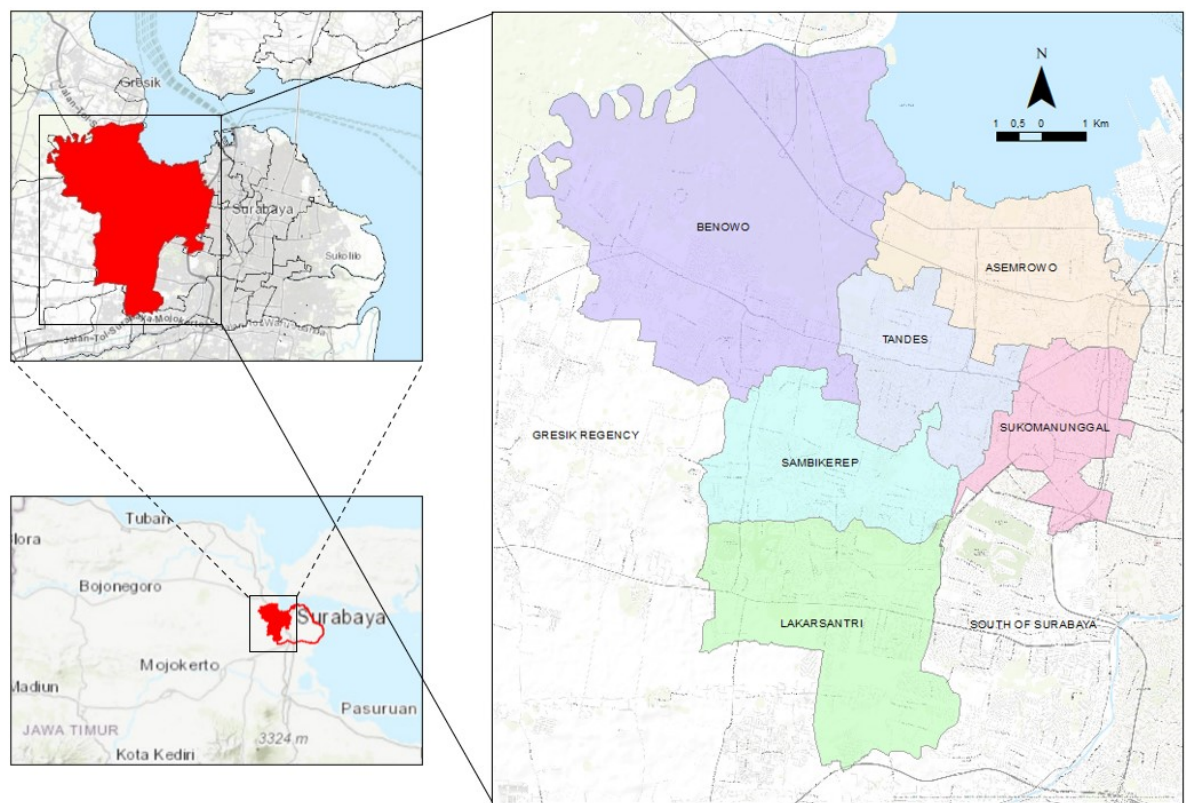
Figure 1. Study area.